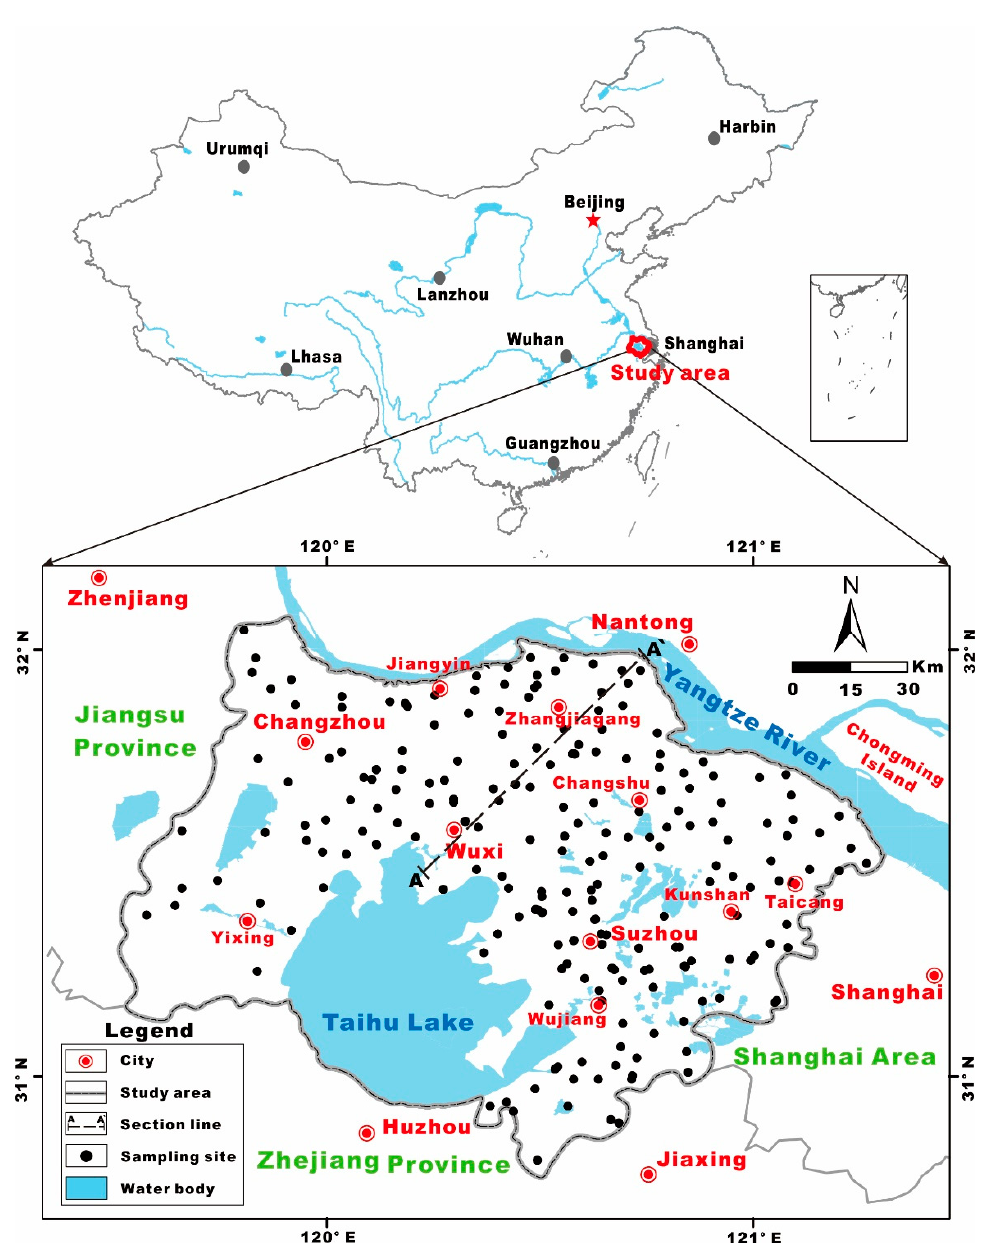
Figure 1. The geographic location of the Su-Xi-Chang region with the sampling sites.